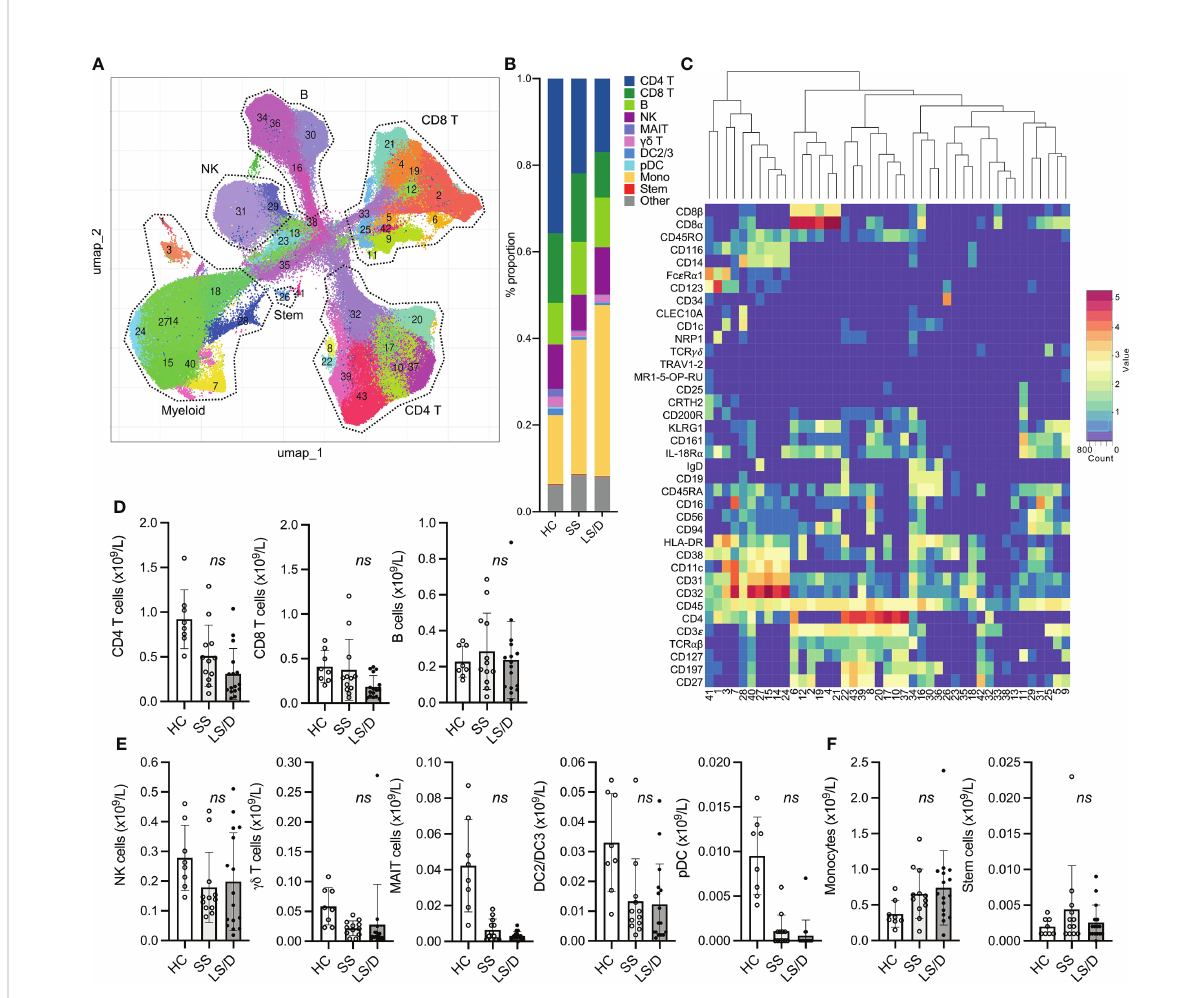
FIGURE 2 Major PBMC subsets fail to identify Long-Stay/Died patients (Replication Cohort). UMAP projection of ungated CyTOF-derived data from the replication cohort (n=28) (A) . Proportion of immune cell subsets in Healthy Controls (HC), Short-Stay (SS) and Long-Stay/Died (LS/D) patient outcome groups (B) . Mean marker expression heatmap of clusters shown in A (C) . Absolute counts of adaptive PBMC subsets (CD4 T, CD8 T, B) (D) , innate and unconventional subsets (NK, MAIT, gd T, pDC, DC2/3) (E) , monocytes and stem cells (F) . ns, p ≥ 0.05 by two-tailed, two-sample unequal variance Student ’ s